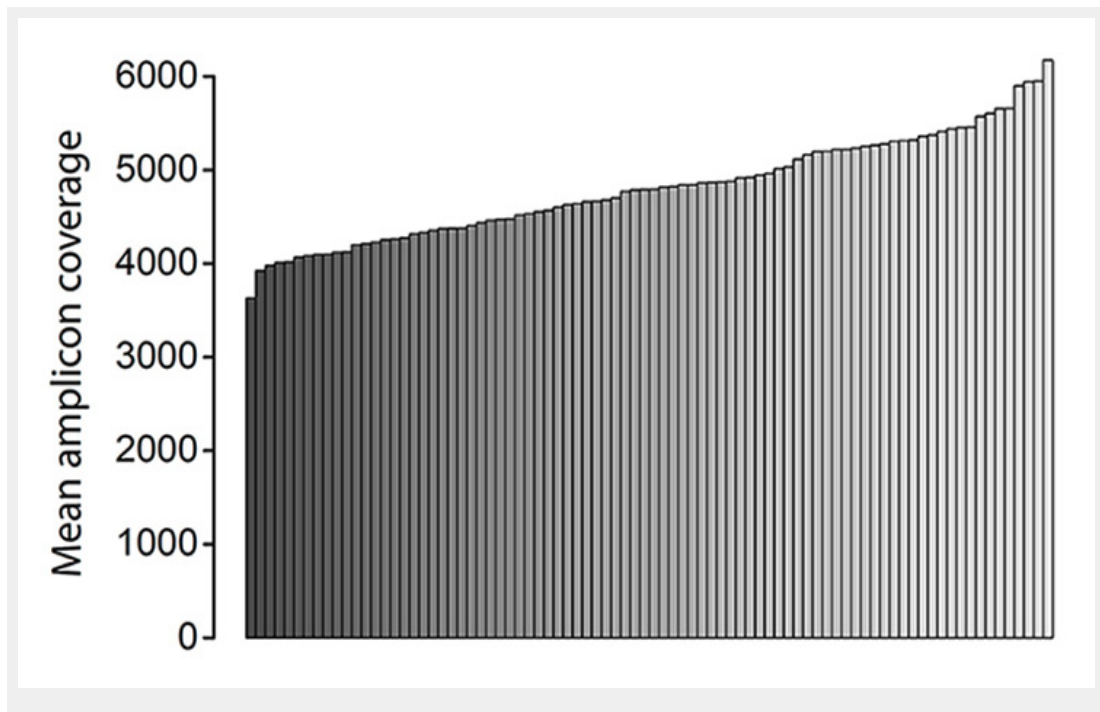
Figure 2 Mean amplicon coverage . Each bar corresponds to one of the 84 samples tested in the second sequencing run. Samples are ranked from the lowest to the highest fold-coverage value. Fold-coverage values of the first 10 samples ranged from 44 978 to 53336 (data not shown).